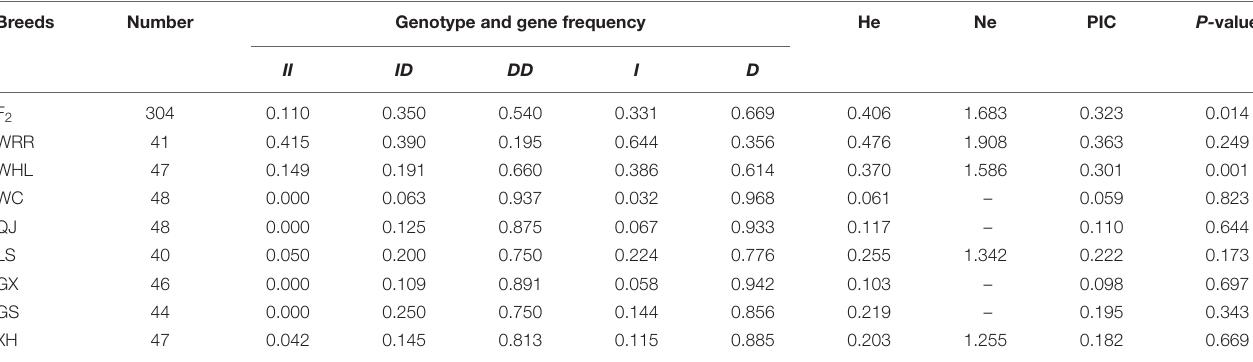
TABLE 1 | Genetic parameters of the 61-bp locus within RIN2 in chicken breeds.